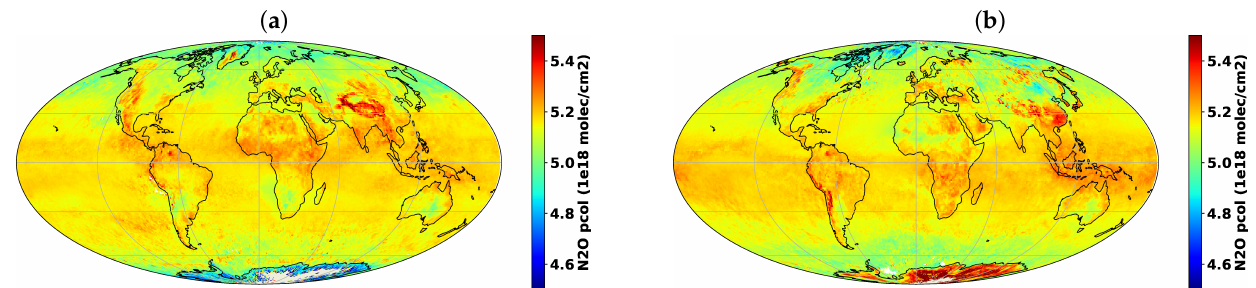
Figure 5. Retrieved N 2 O partial column from 800 to 80 hPa (monthly average) for ( a ) June and ( b ) December 2018.